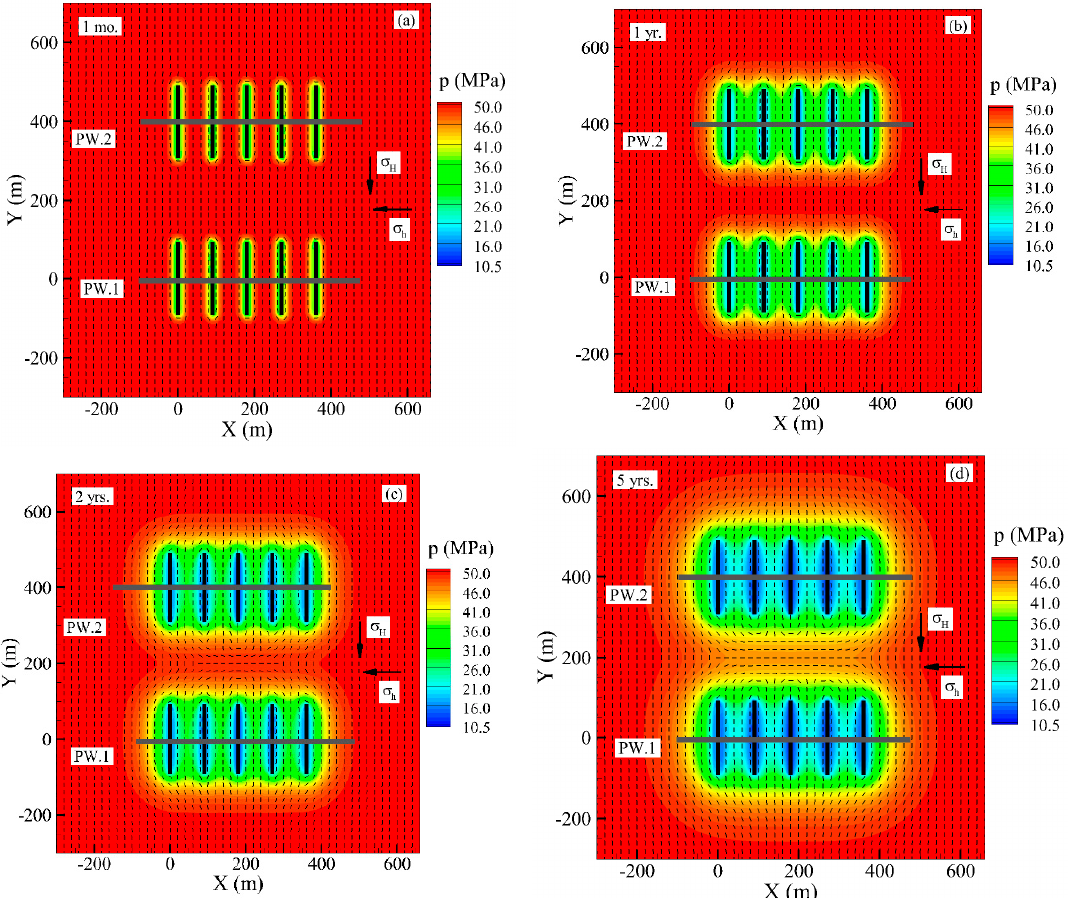
Figure 17. Distribution of reservoir pore pressure distribution and trajectories of the local maximum principal stress after ( a ) 1 month ( b ) 1 year ( c )2 years and ( d ) 5 years of production. The fluid diffusion front is advancing, and after approximately 2 years of production time, we can notice that